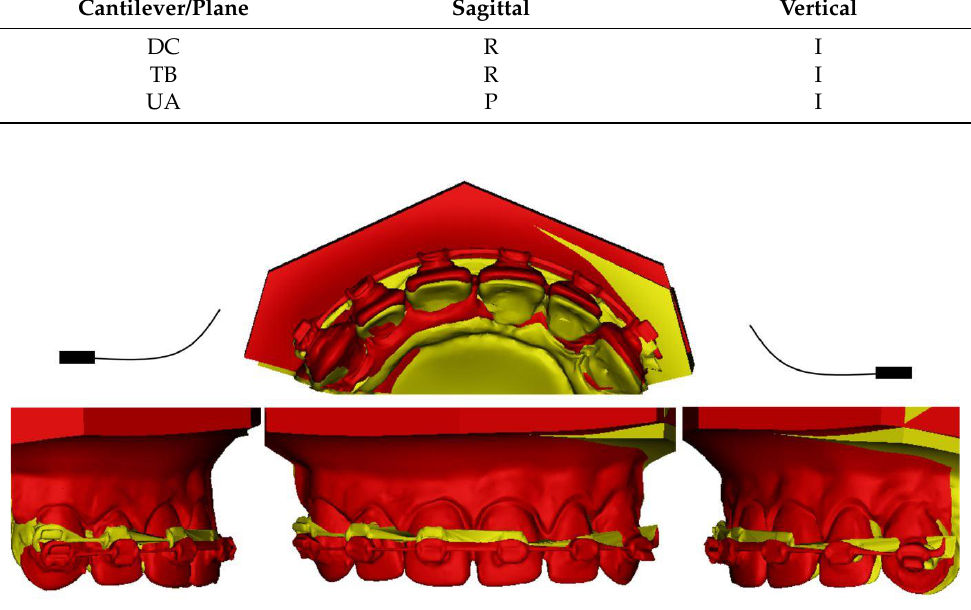
Figure 3. Symmetric activation of 10 mm DC (T0: red, T1: yellow).